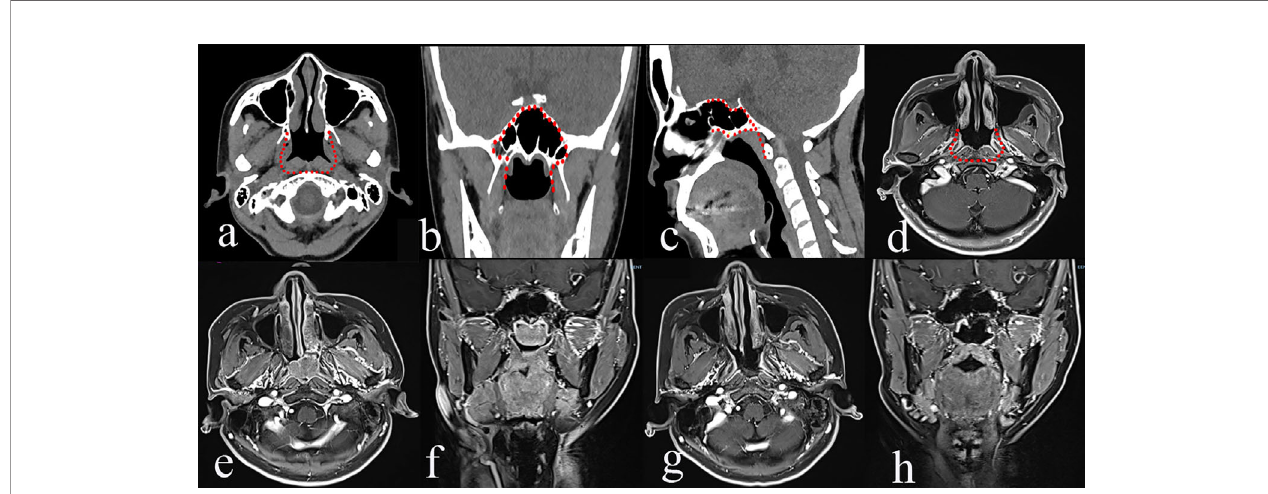
FIGURE 1 | The greatest extent of resection in Type I transnasal endoscopic nasopharyngectomy (TEN) [red dot line in a – d ], pre-operative magnetic resonance imaging (MRI) of rT1 nasopharyngeal carcinoma (NPC) (e, f) , and post-operative MRI (g, h)